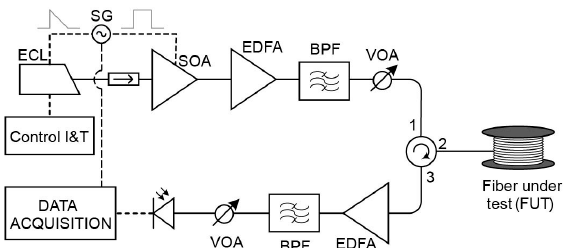
Figure 2. Setup of CP- Φ OTDR. ECL: External cavity laser; SG: Signal generator; I&T: Intensity and temperature; SOA: Semiconductor optical amplifier; EDFA: Erbium doped fibre amplifier; BPF: Band-pass filter; VOA: Variable optical attenuator; FUT: Fibre under test; PD: Photodetector. Solid line represents optical path, dashed line represents electrical path.